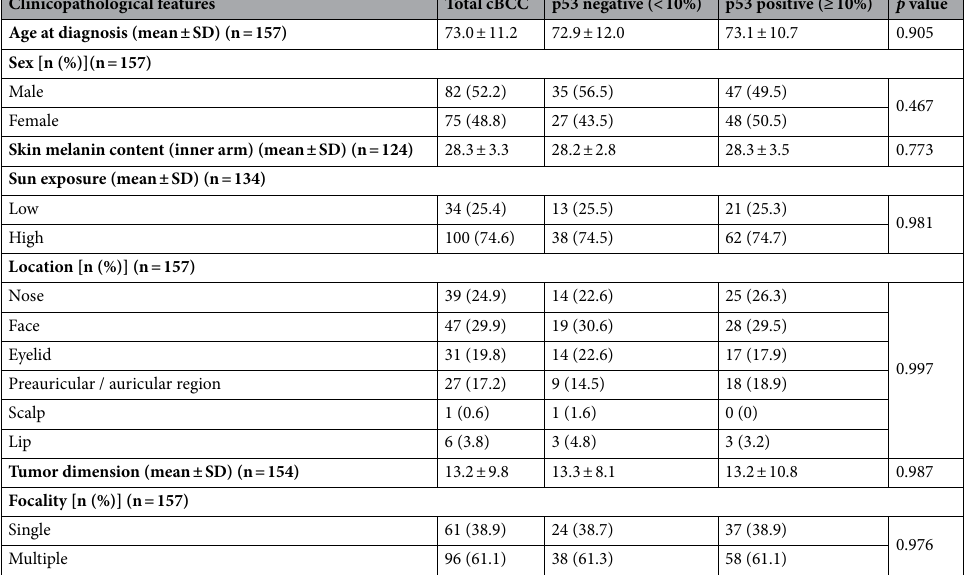
Table 1. Clinicopathological features and p53 expression in cBCCs.